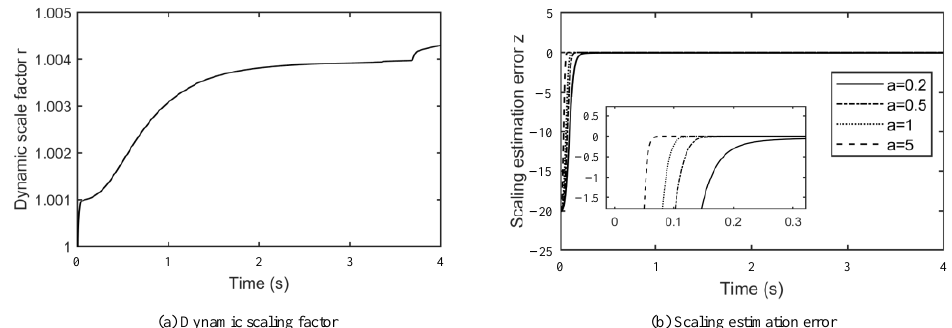
Figure 4. Dynamic scaling factor and scaling estimation error with different supervision factors.